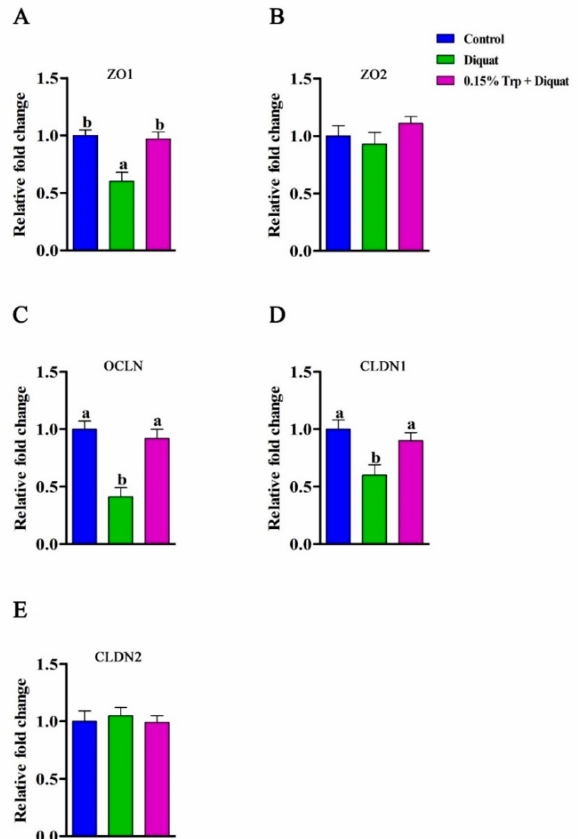
Figure 2. E ff ects of dietary tryptophan supplementation on mRNA expression of tight junction proteins in piglets challenged with diquat. ( A ) ZO1 , zona occludens1; ( B ) ZO2 , zona occludens 2; ( C ) OCLN , occludin; ( D ) CLDN1 , claudin1; ( E ) CLDN2 , claudin 2. Data are means ± standard error; n = 8 for each group. Mean values sharing di ff erent superscripts within the same row di ff er significantly ( p < 0.05). Control, piglets fed the basal diet without diquat injection; diquat, piglets fed the basal diet and challenged with diquat; 0.15% Trp + diquat, piglets fed the 0.15% supplemented diet and treated with